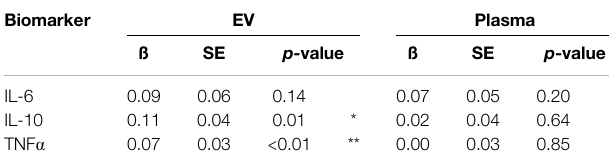
TABLE 3 | Regression models estimating the predictive value of PSQI score on cytokine levels (standardized) in mTBI patients. All models control for